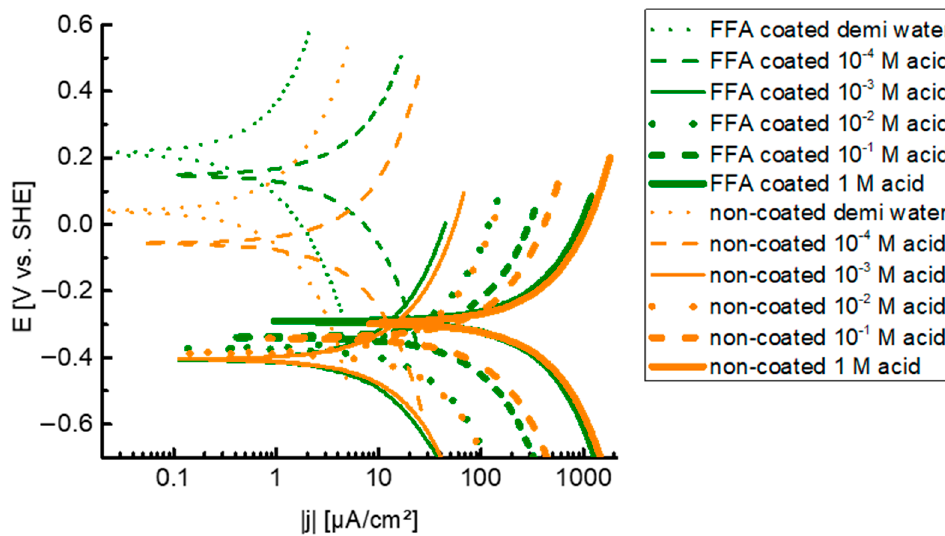
Figure 13. Representative polarisation curves of non-coated and FFA-coated NiCrMoV steam turbine steel in different concentrations of acetic acid at 90 °C.